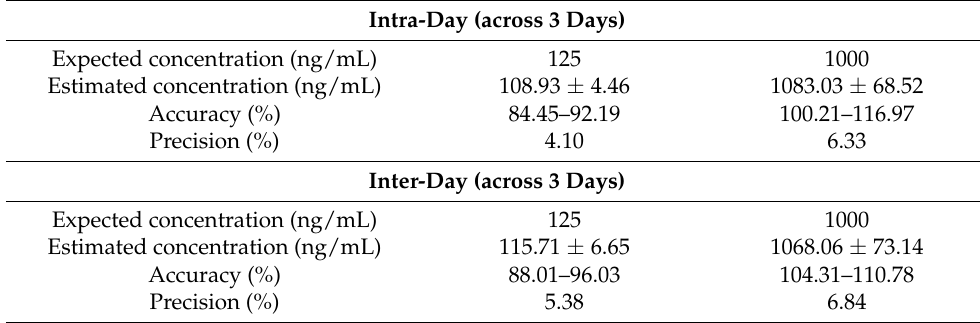
Table 2. Mean ± SD of the intra- and inter-day QC samples as triplicates dosed with doxycycline at different concentrations (125 and 1000 ng/mL), with the accuracy (%) and precision (%) of the intra-day and inter-day results across three